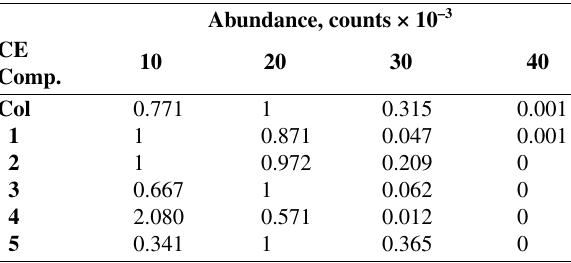
Table 5. Abundances (measured in counts) of precursor ions [ M+H ] + at different values of collision energy CE (eV) for Col and 1–5